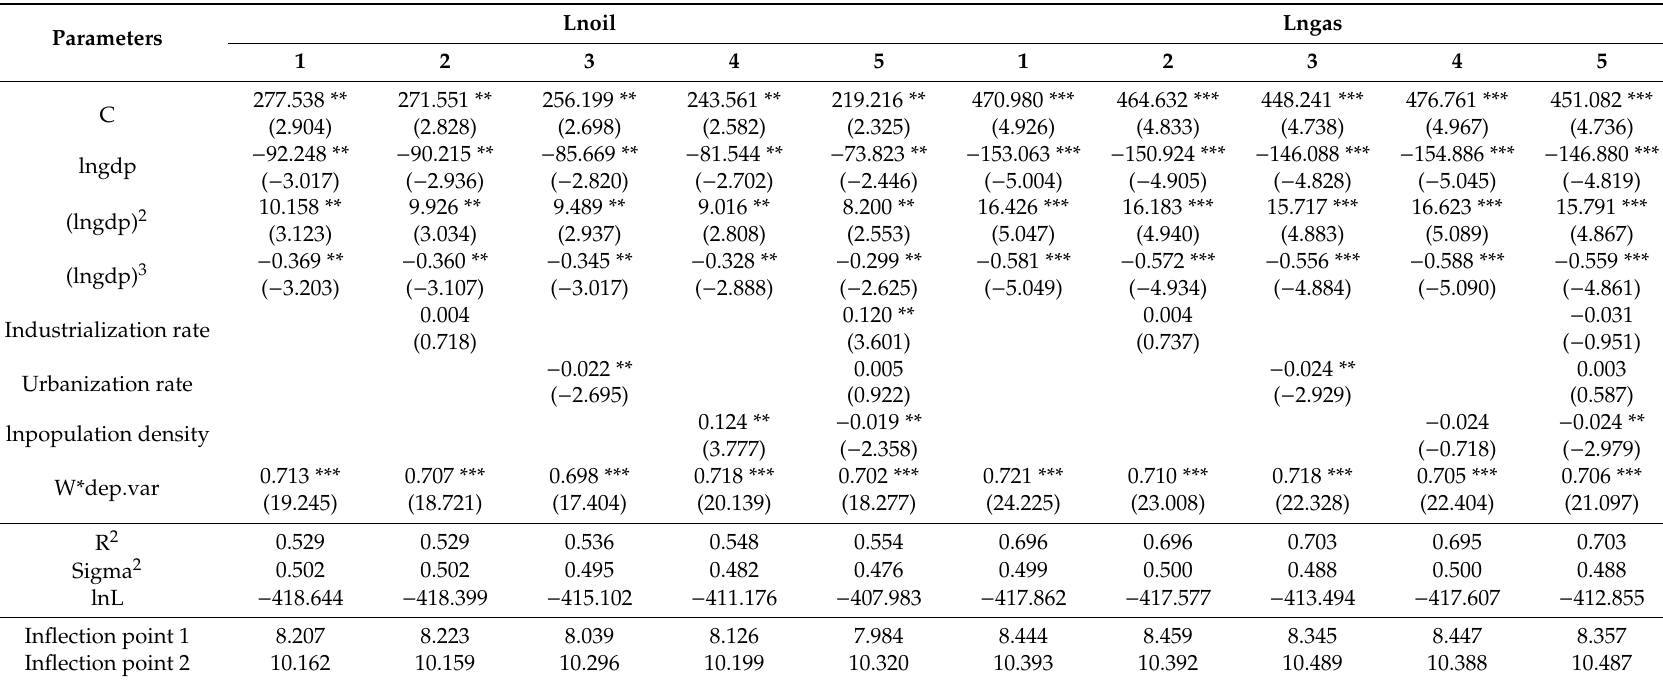
Table 7. Spatial lag model estimation results of mixed OLS e ff ect of total oil consumption and total gas